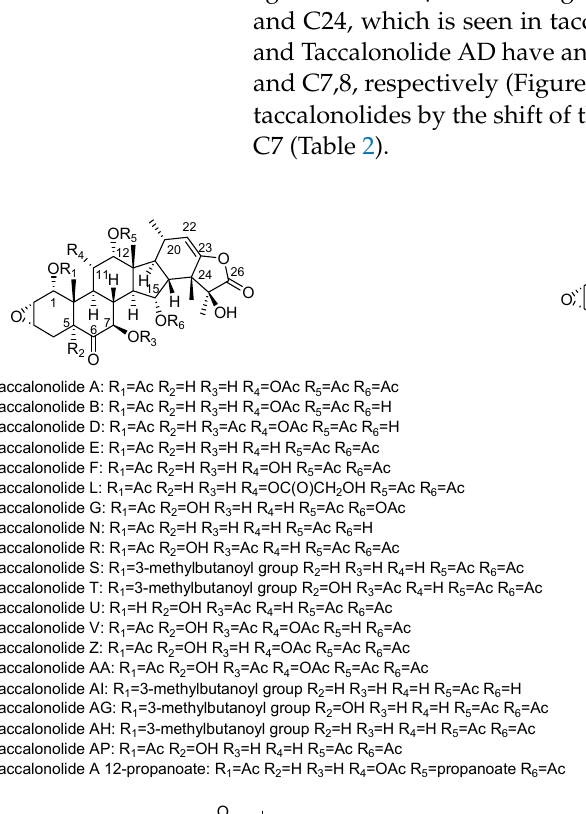
R=HH taccalonolide AW: R=OAc taccalonolide AX: Figure 2. Structures of naturally derived taccalonolides. Figure 2. Structures of naturally derived Table 2. Selective natural taccalonolides with rare substructures or substituents.